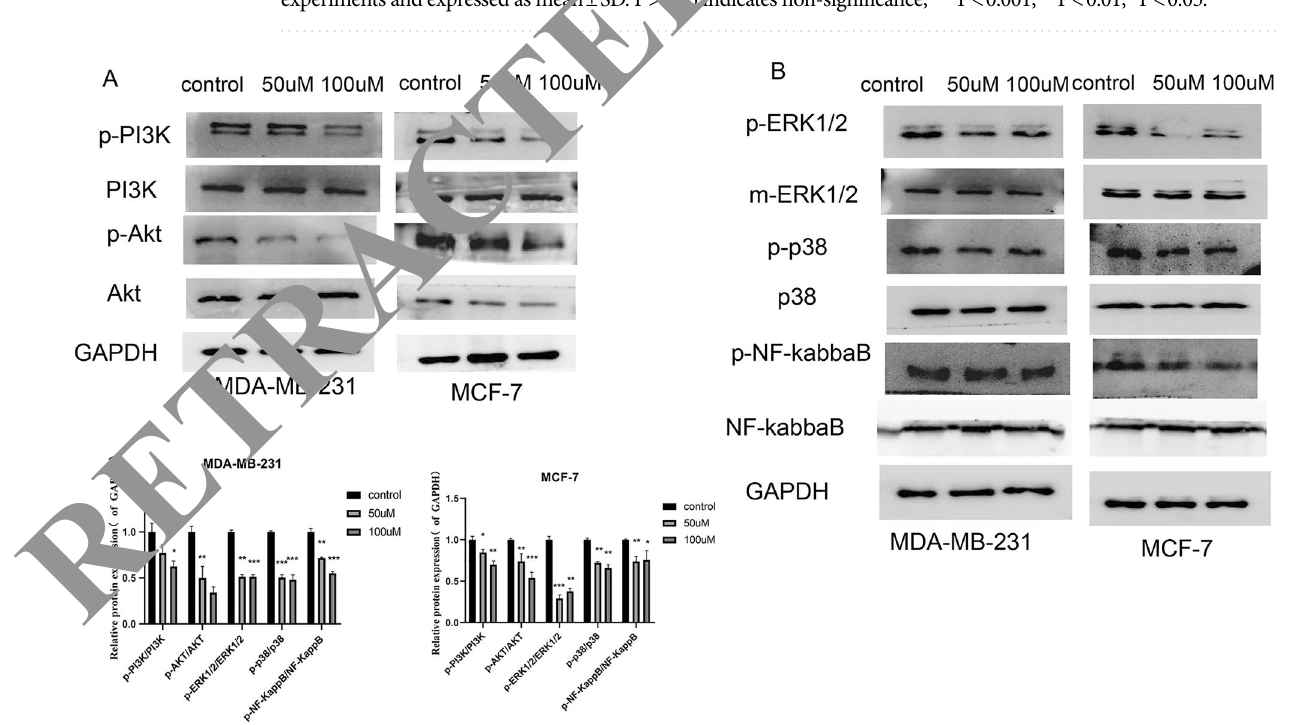
Figure 4. Effect of Eupafolin on PI3K/AKT, MAPKs and NF-κB signaling in breast cancer cells. ( A , B ) Eupafolin treatment leads to decreased phosphorylation of PI3K/AKT, Erk1/2, p38, and NF-κB/p65 by western blotting. Full- length images are presented in Supplementary Figs. 5 and 6. Graphs of signal intensity were obtained through band densitometry and referred to GAPDH and control levels. Data is representative of three independent experiments and expressed as mean ± SD. P > 0.05 indicates non-significance; ***P < 0.001; **P < 0.01; *P <